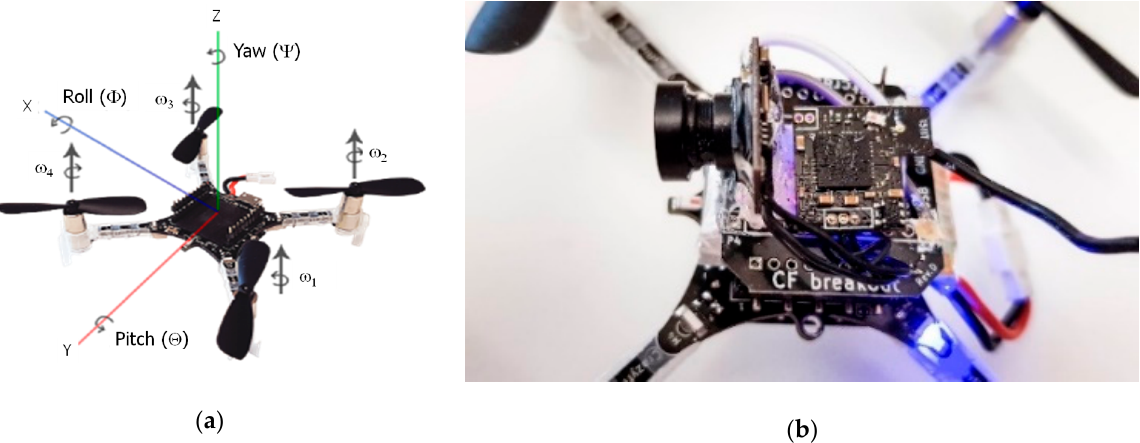
Figure 1. ( a ) Crazyflie 2.0 commercialized by Bitcraze AB; ( b ) the camera and transmitter module was mounted on top of the Crazyflie 2.0.